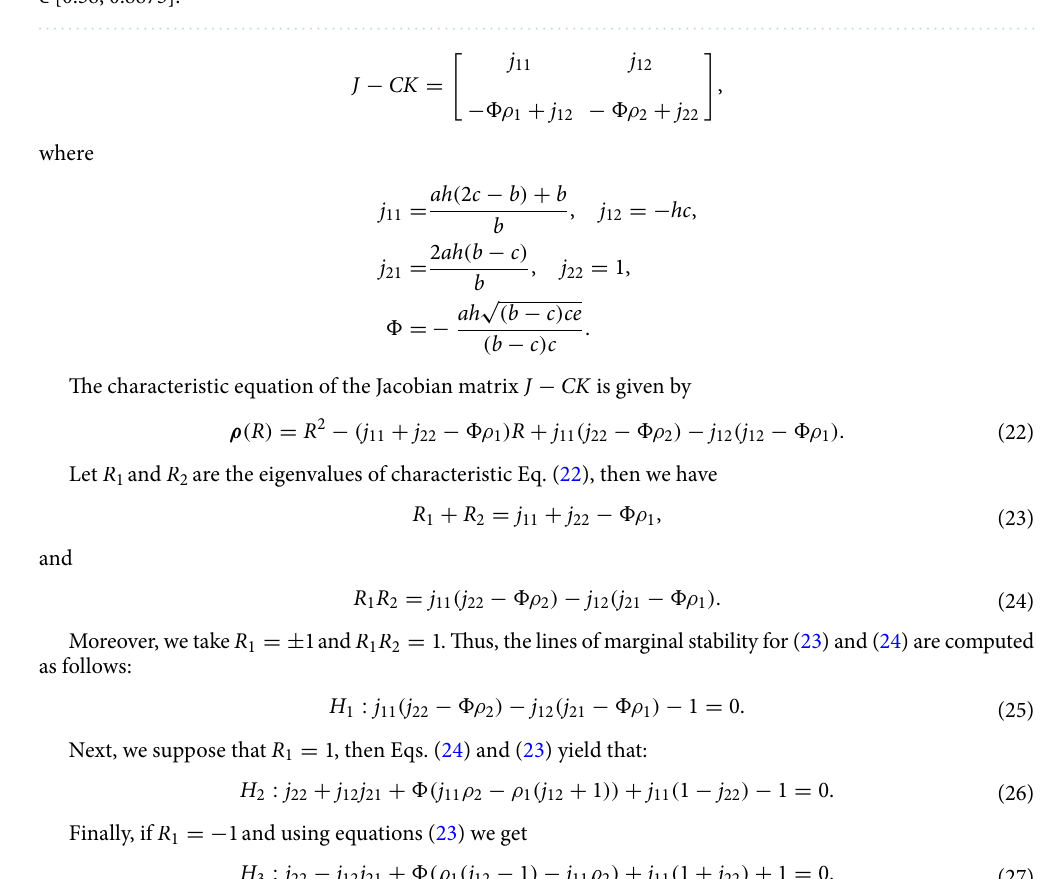
Figure 2. Bifurcation diagrams and ML exponents for the model (i) for values of a = 4, b = 2, c = 0.1, e = 0.7, h ϵ [0.58,